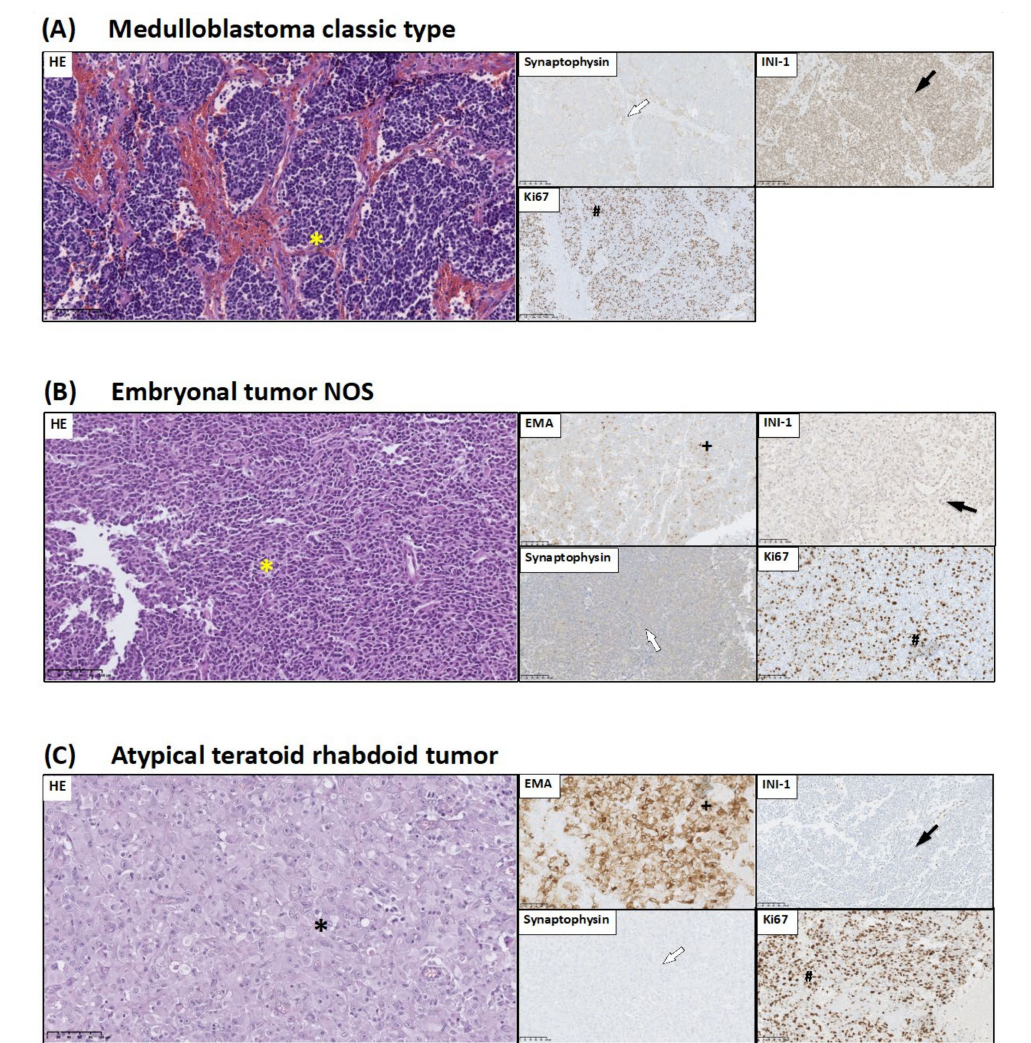
Figure 3. Histological and immunohistochemical staining of group 3 pediatric brain tumors: medulloblastoma classic type, embryonal tumor NOS, and AT/RT. HE staining as well as synaptophysin, Ki67, INI-1, and EMA immunohistochemical staining were performed to visualize typical manifestations in these types of tumor tissue. The picture shows the typical staining of a representative sample from each type of tumor. ( A ) Medulloblastoma classic type: small round neoplastic cells with scant cytoplasm (*). Neoplastic cells positive for synaptophysin immunostaining (white arrow). Immunoexpression of INI-1 in neoplastic cells (black arrow). High Ki67 LI in tumor tissue (#). ( B ) Embryonal tumor NOS: primitive neoplastic cells (*). Neoplastic cells with dot-like reaction of EMA (+). INI-1 immunostaining in some neoplastic cells (black arrow). Weak reaction for synaptophysin (white arrow). High Ki67 LI in tumor tissue (#). ( C ) AT/RT: rhabdoid cells in HE staining (*). Neoplastic cells strong positive for EMA immunostaining (+). Lack of INI-1 immunoexpression in neoplastic cells (black arrow). Weak reaction for synaptophysin (white arrow). High Ki67 LI in tumor tissue (#). Preparations were scanned at original magnification 40 × , and digital magnification presented on image is 20 × for HE and 5 × for immunohistochemical